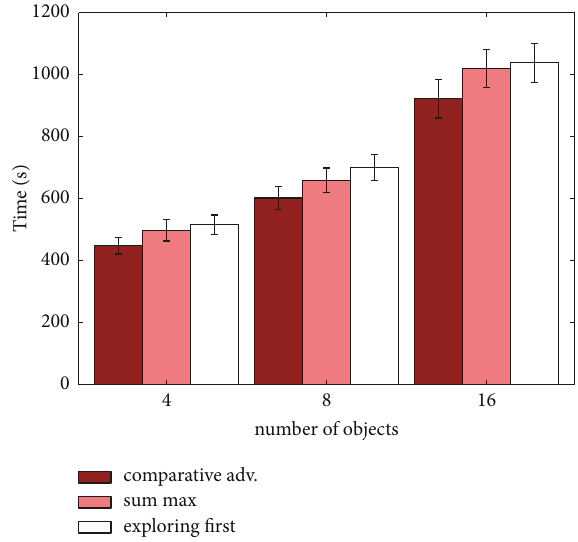
Figure 8: Results of proposed and conventional